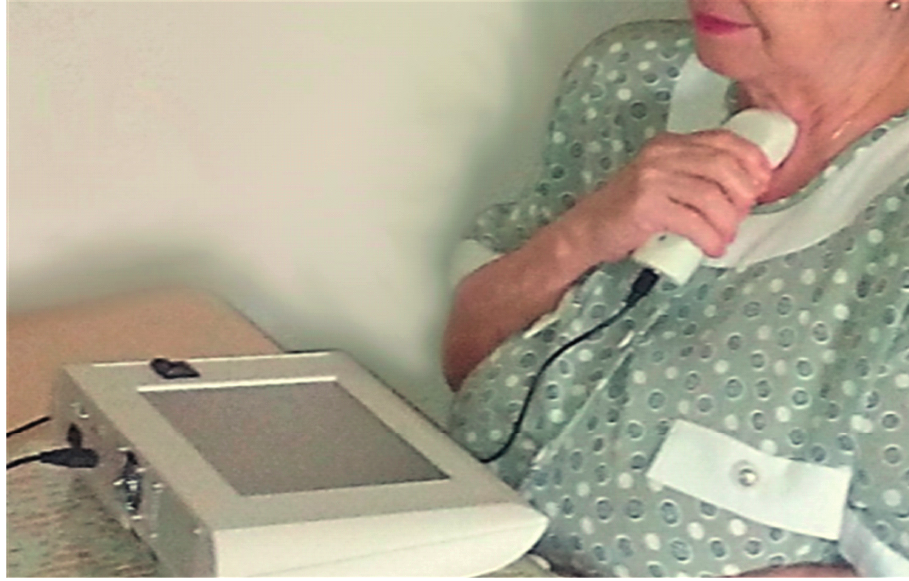
Figure 2. Photograph of a subject using the respiratory sensor at home during the process of respiratory sounds acquisition at the suprasternal notch. The base-station assistant steps the user through the process. The process is guided by the base station using visual and voice instructions for